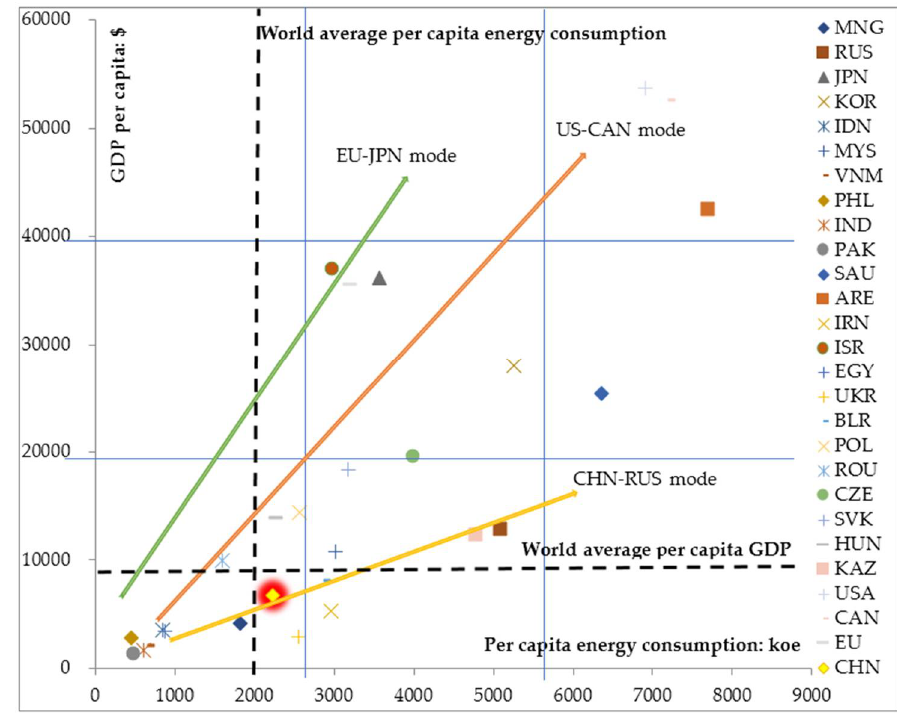
Figure 3. Per capita GDP and per capita energy consumption in 27 major countries in 2013. Note: koe means kg oil equivalent.